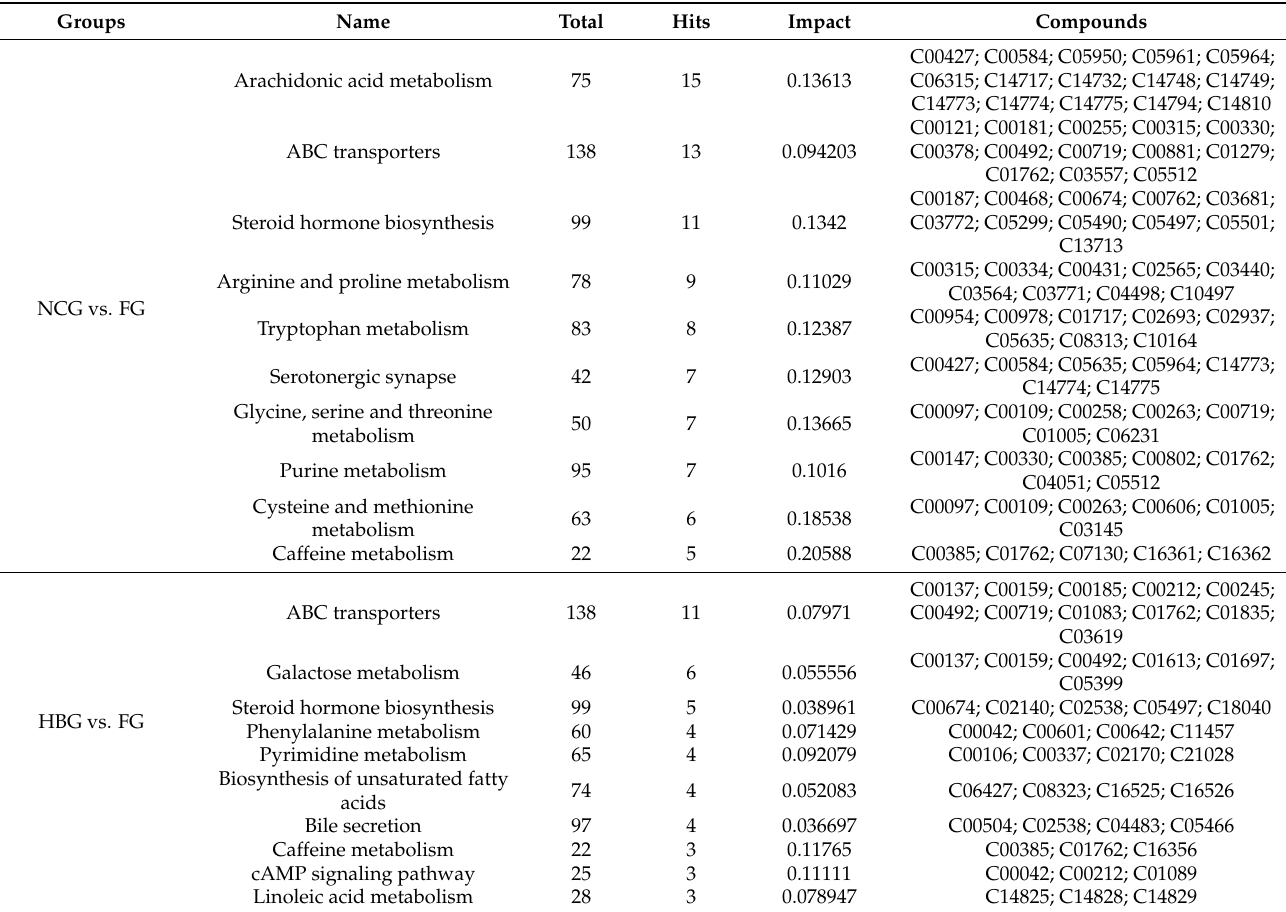
Figure 8. The related corrections between gut microbial composition based on genus level and significantly differential metabolites. * indicates a significant difference at p < 0.05; ** indicates a significant difference at p < 0.01. Table 6. Metabolic pathway analysis based on significantly differential